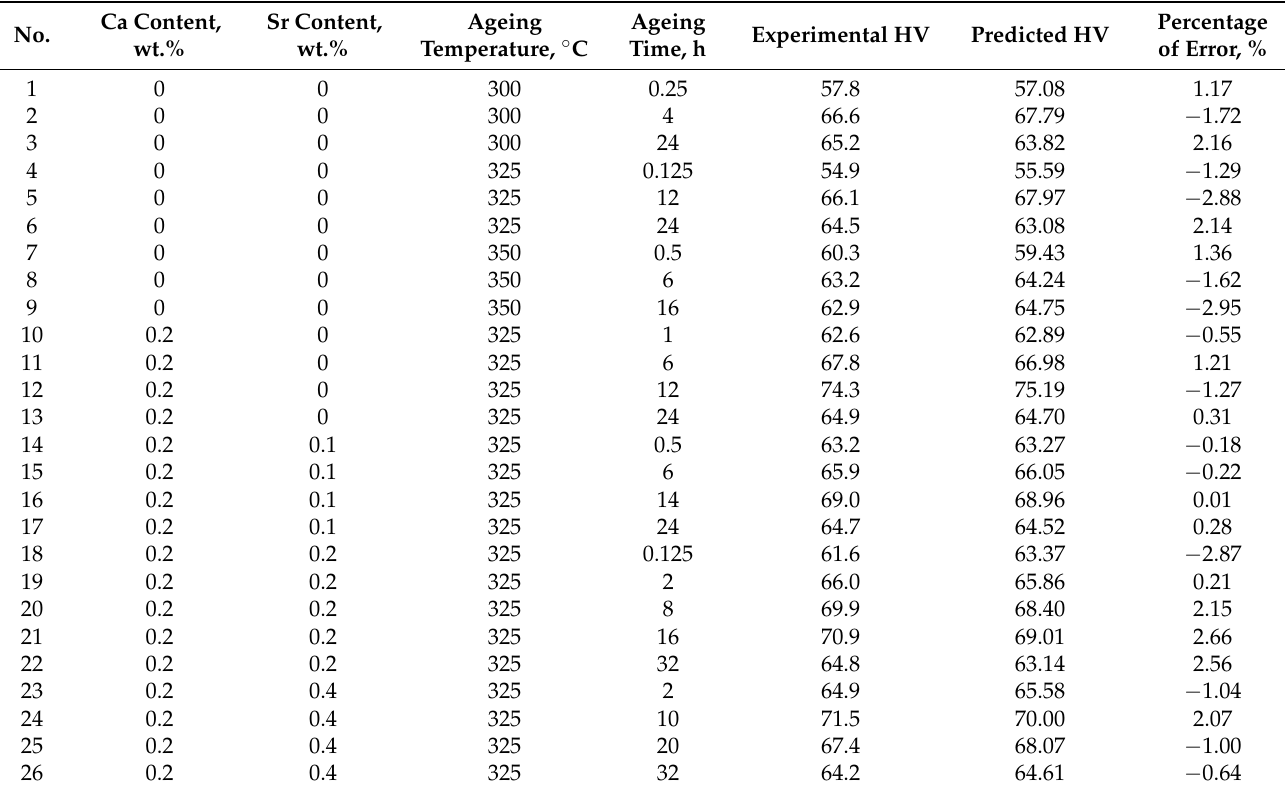
Table 4. Experimental data and BP predicted results.